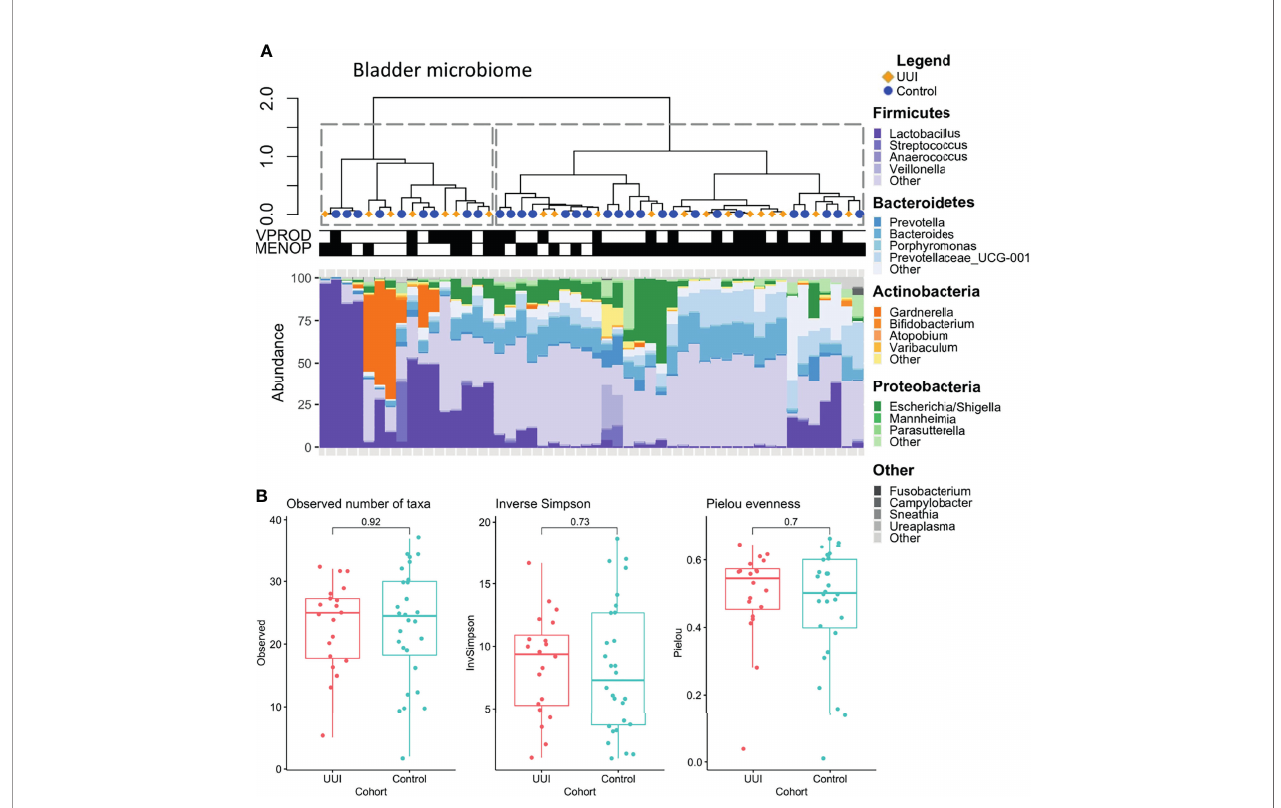
FIGURE 3 | (A) Clustering of bladder microbiome is associated with menopausal status. Hierarchical clustering was performed using the Ward ’ s minimum variance method on weighted UniFrac distances between samples. Dotted lines outline clusters that were chosen based on the Silhouette metric. Black bars underneath annotate for clinical features being true. Menopausal status was associated with bladder microbiome cluster (p = 0.01), but vaginal product use was not (p =1.0, Fisher ’ s exact test). Cases are labeled with yellow diamonds and controls are labeled as blue squares. MENOP, post-menopausal. (B) Women with and without UUI do not differ in bladder microbiome diversity. Alpha diversity is visualized using box-and-whisker plots and measured using observed number of taxa (genera, p = 0.92), inverse Simpson Index (p = 0.73), and Pielou evenness index (p= 0.70). A generalized linear model was used to adjust for age, BMI, and menopause-estrogen